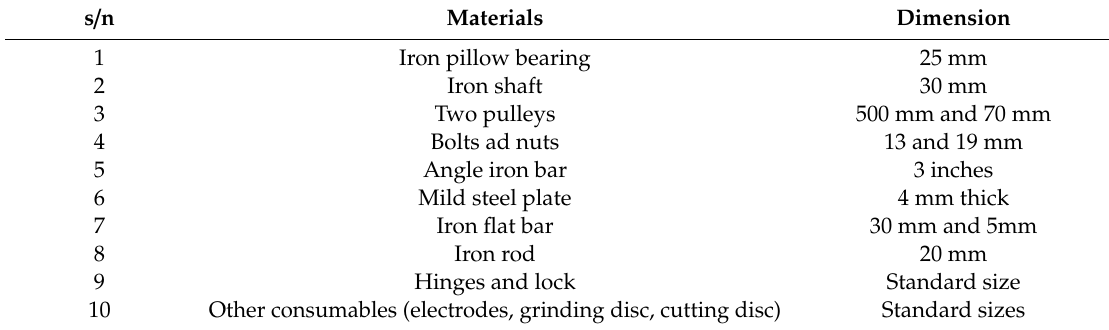
Table 2. Materials for fabrication of the tuber peeling